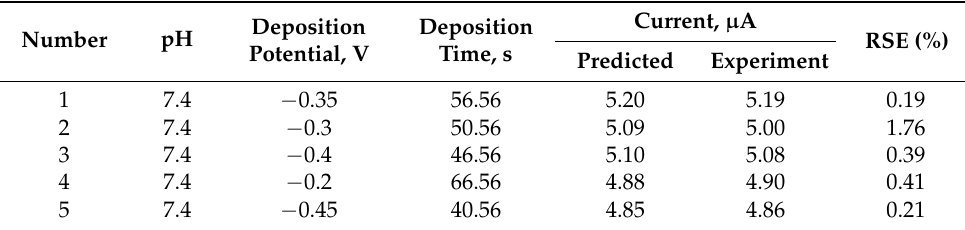
Table 2. Predicted and observed response values performed at optimum conditions of uric acid detection by